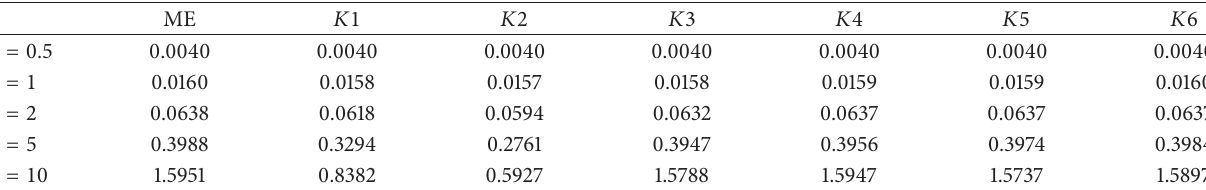
Table 11: Estimated MSE with 𝑛 = 150 , 𝑝 = 4 , and 𝛾 = 0.95 .